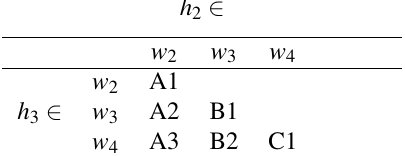
Table 4. Different Cases of Structure of D 2 α ( g ) when g = h 2 ∈